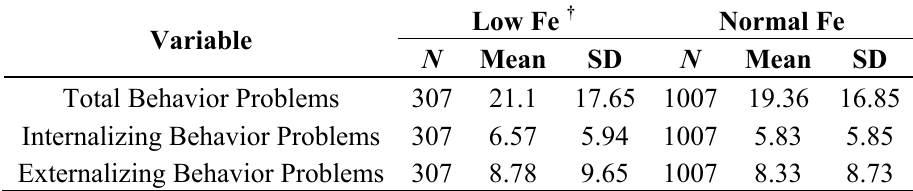
Table 3. Children’s behavior problems by Fe level ( N = 1314).